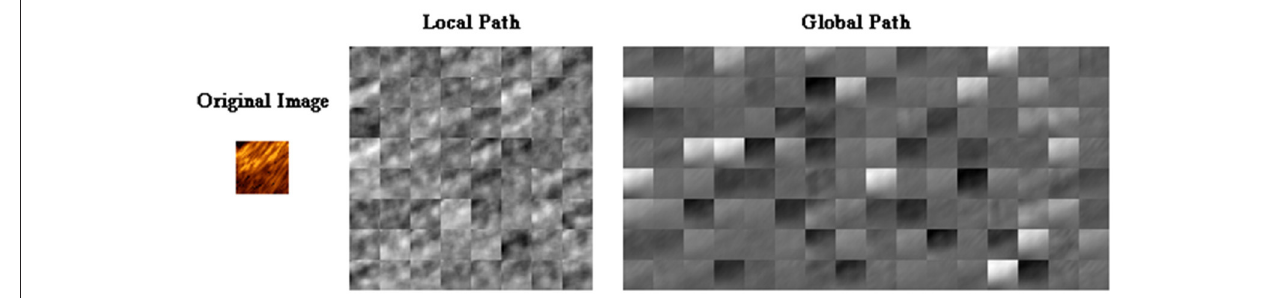
FIGURE 5 | The activations of convolutional layers in the local path and the global path from a randomly selected patch. The activations can take any value, so the value is normalized to the range from 0 to 1 for visualization. Here, white pixels represent a strong positive activated region and black pixels represent a strong negative one. The channel is mostly gray if it does not activate as strongly on the original image.